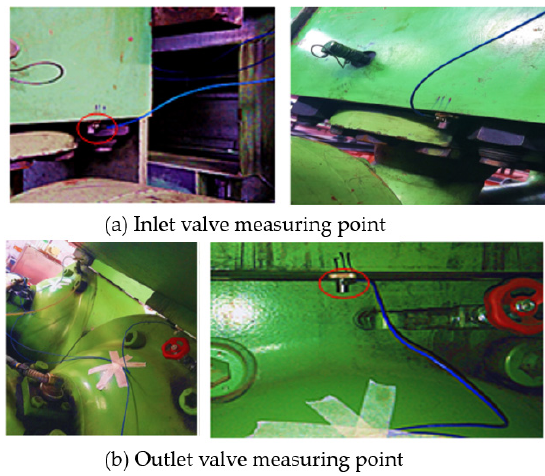
Figure 8. Acceleration sensor positions